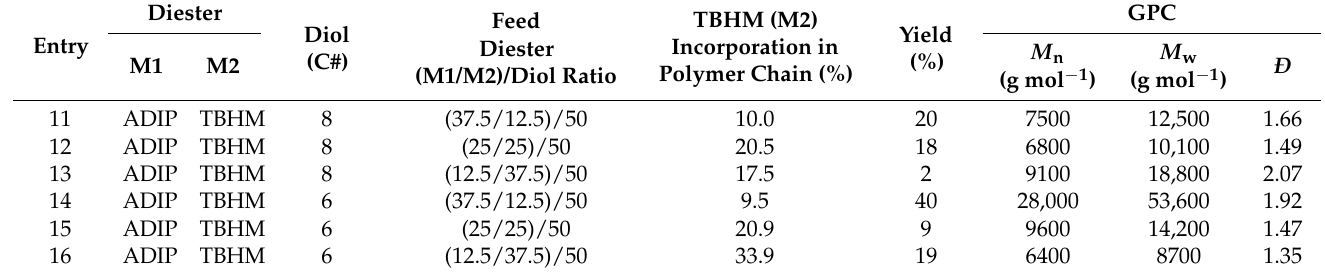
Table 2. Yield and molar mass of copolymers obtained from the polymerization of adipic acid, TBHM, and diols.